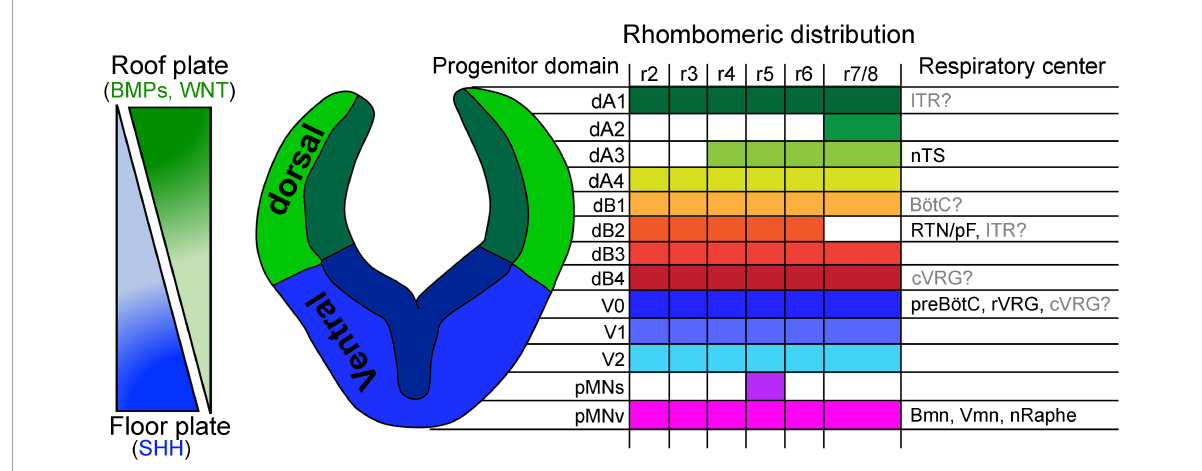
FIGURE3 Dorsal to ventral patterning of the developing brainstem. Left, schema illustrating concentration gradients formed by the diffusion of bone morphogenic proteins (BMPs)/WNTs and Sonic hedgehog (SHH) morphogens produced by the roof and floor plate, respectively. Right, schema illustrating a transverse section of the developing hindbrain and the patterning of 13 progenitor domains along its dorsal-ventral axis. These progenitors emerge from the differential action of BMP/WNT/SHH concentration gradients. The rhombomeric distribution of each progenitor domain and contribution to brainstem respiratory centers are indicated. Of note, the origin of the intertrigeminal region (ITR), Bötzinger complex (BötC) and caudal ventral respiratory group (cVRG) has not been conclusively determined (see text). nTS, nucleus tractus solitarius; RTN/pF, retrotrapezoid/parafacial nucleus; preBötC, preBötzinger complex; rVRG, rostral ventral respiratory group; Bmm, branchial motor neurons; Vmn, visceral motor neurons; nRaphe, Raphe nuclei. This figure is adapted from our previous publication Isik and Hernandez-Miranda (2022) in Handbook of Clinical Neurology, Chapter 5, entitled Early development of the breathing network, published by Elsevier Books. The license number 5392080585902 between Hernandez-Miranda, Charite Universitätsmedizin Berlin and Elsevier allows us the reuse of it in a journal/magazine.